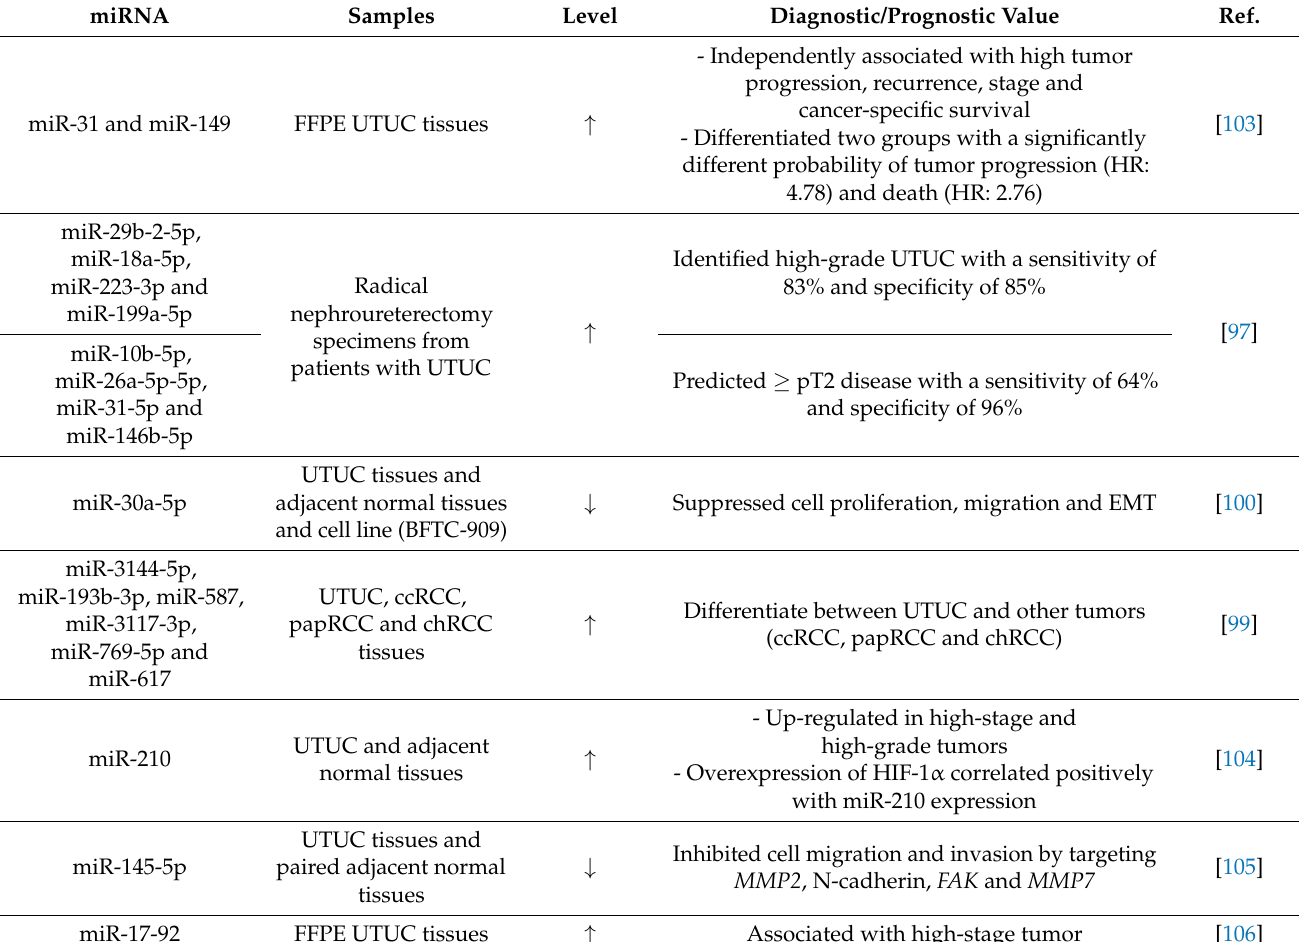
Table 3. miRNAs and their diagnostic and/or prognostic values in upper tract urothelial carcinoma. miRNA Samples Level Diagnostic/Prognostic Value Ref.